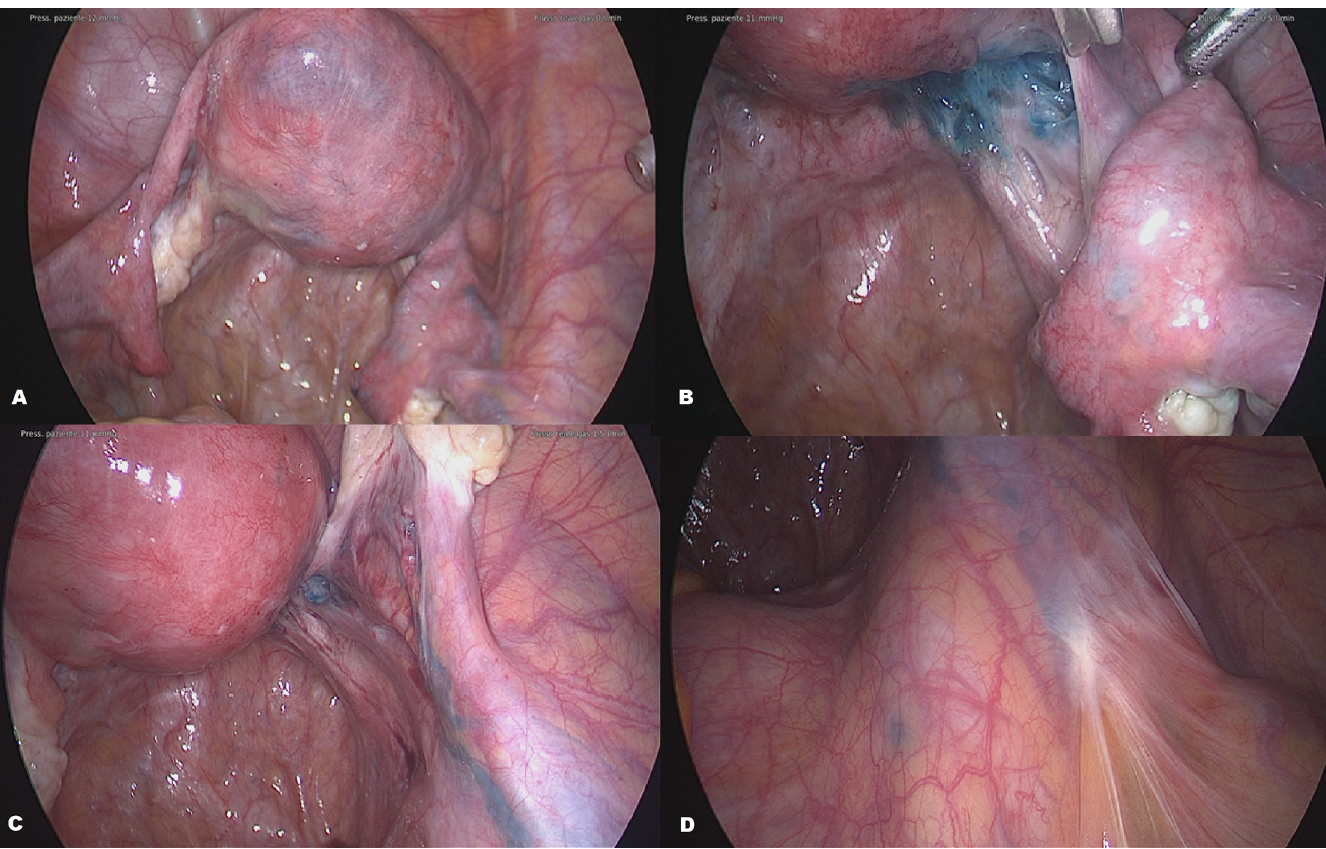
Fig 2. Laparoscopic images during a tubal dye test. The uterus showed a transient scattered blue color and unilateral right tubal permeability was demonstrated (A). A deep blue color of the endometriosis nodule of the right uterosacral ligament appeared after a few seconds (B) along with a progressive staining of lymphatic vessels of the infundibulopelvis ligament (C). A blue spot was seen where lymph nodes of the internal iliac vein lie (D).